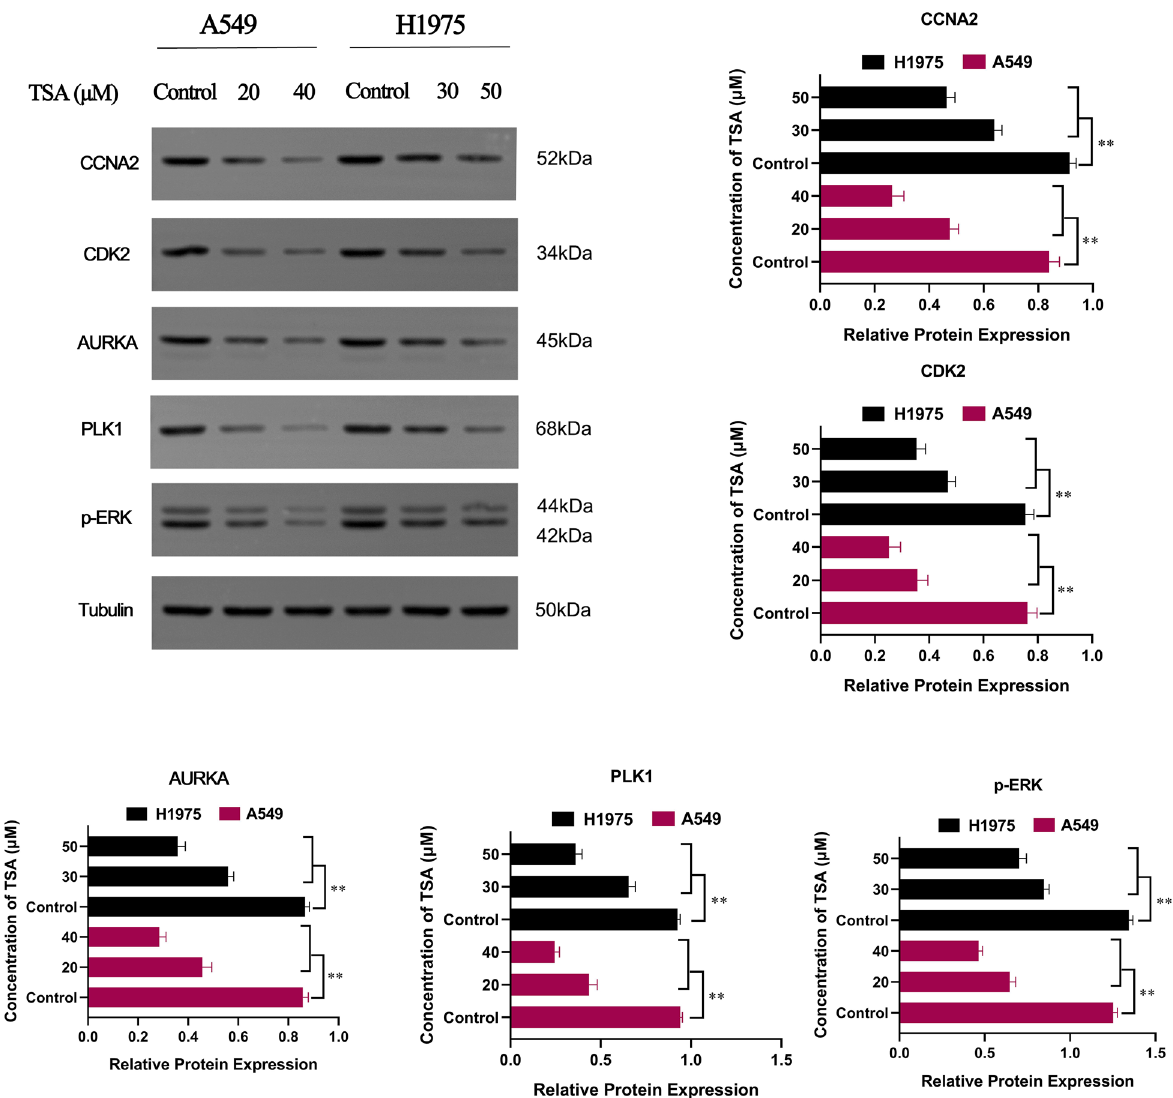
Figure 8. Expressions of CCNA2, CDK2, AURKA, PLK1, and p-ERK were detected using western blot assay. Quantitation of the western blot analysis for CCNA2, CDK2, AURKA, PLK1, and p-ERK compared with GAPDH, and ** P < 0.01 versus the control